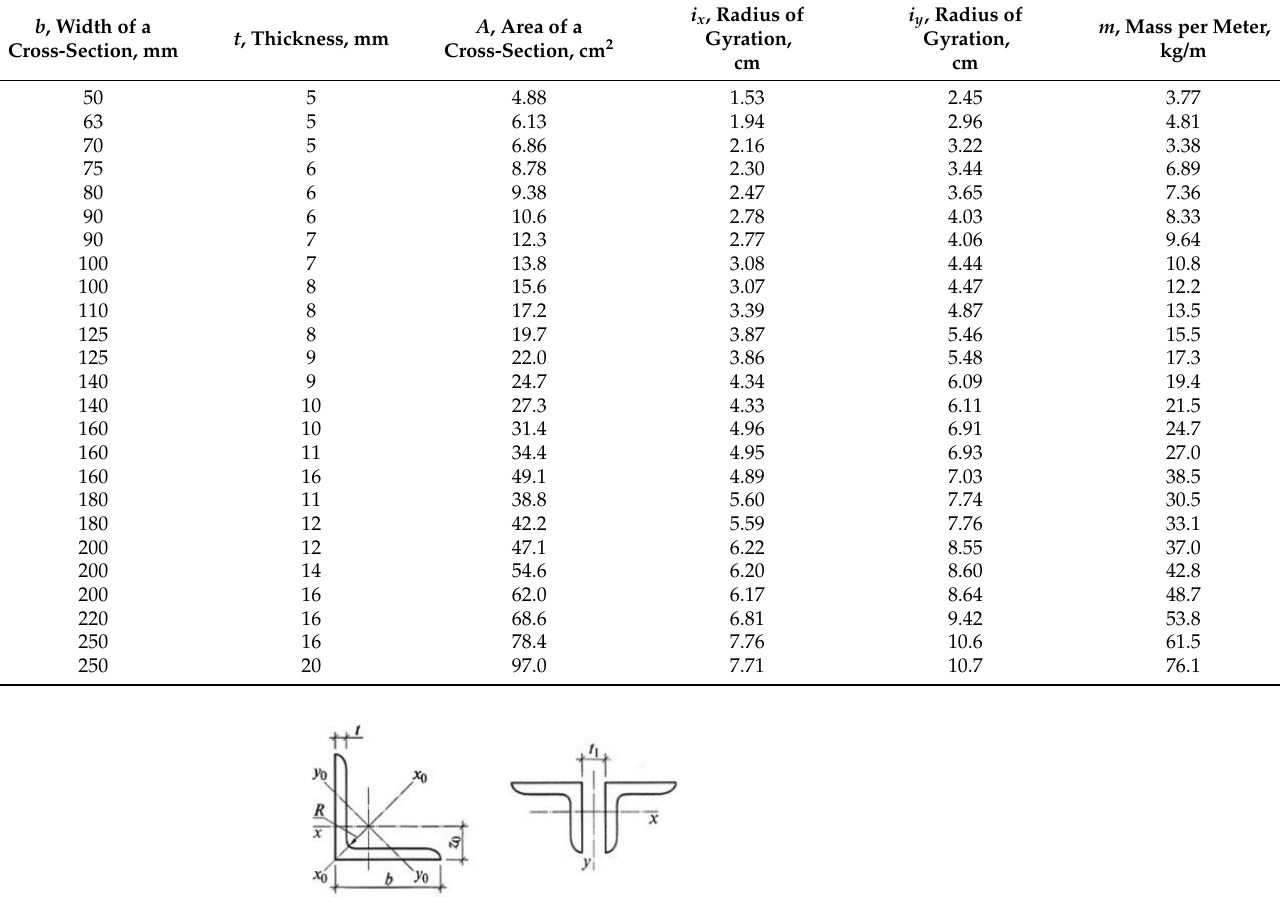
Table 1. Geometric dimensions of the equal-leg angles (back-to-back) by GOST 8509–93 (shortened) of the trusses and by Figure 6.